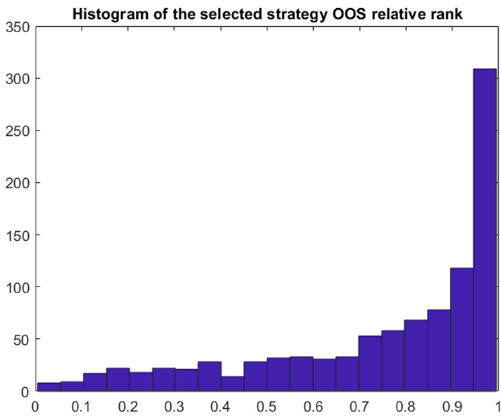
Figure 13. Bayes model 1 histogram of the out-of-sample relative rank of the best IS strategy.